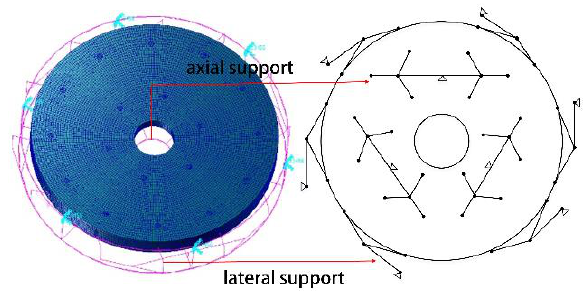
Figure 10. Finite element model of the primary mirror (PM).